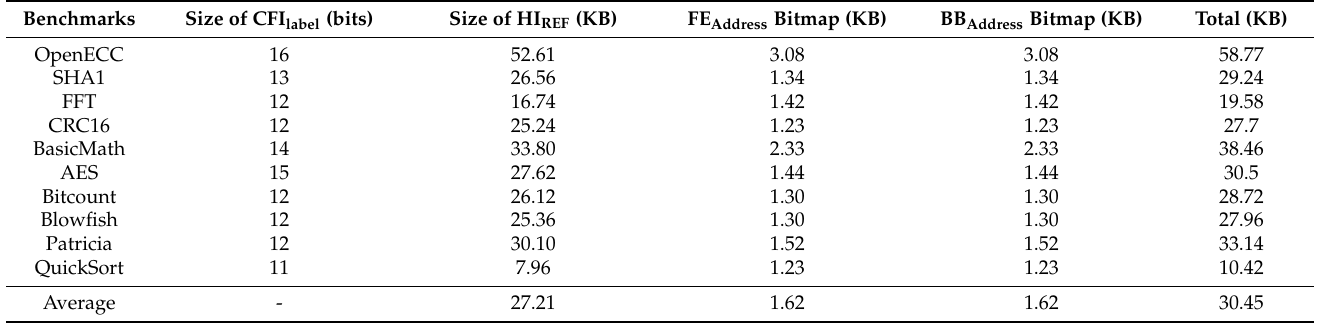
Table 6. The size of the reference information and the bitmap for the selected benchmarks. Benchmarks